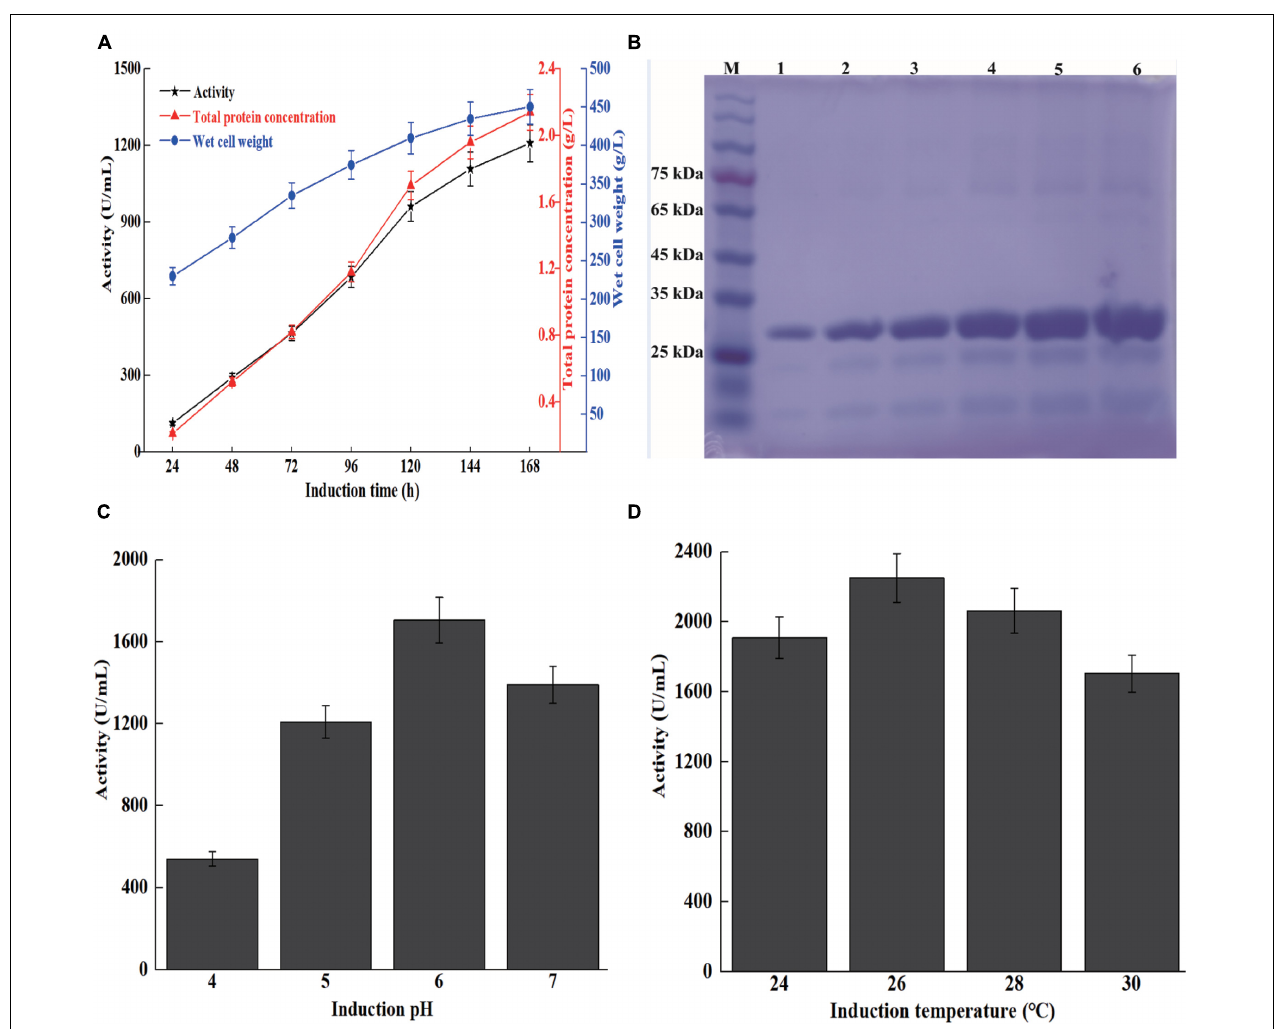
FIGURE 3 | High cell density fermentation of recombinant strain X33-Sh33 in 7-L bioreactor. The chitosanase activity, total protein concentration, and WCW during fed-batch fermentation in 7-L bioreactor (A) . SDS-PAGE analysis of supernatants from different induction times (B) . M represents marker, lanes 1–6 represent supernatant from 48 to 168 h. Influence of induction pH (C) and temperature (D) on the production of Sh